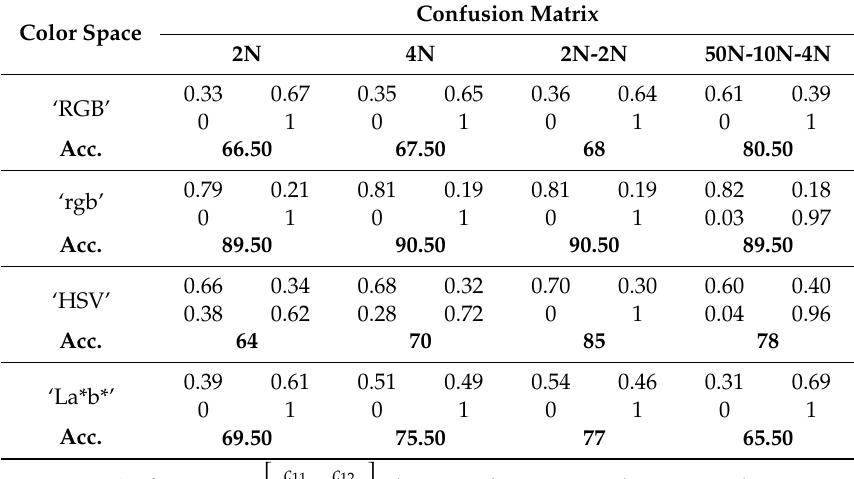
Table 2. Confusion matrix of the results predicted by various MLP